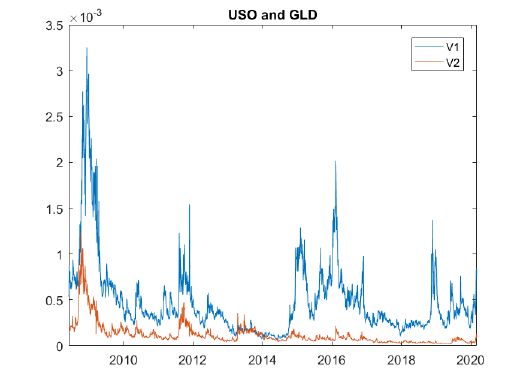
Figure 5. Principal components. Data: USO (OVX) and GLD